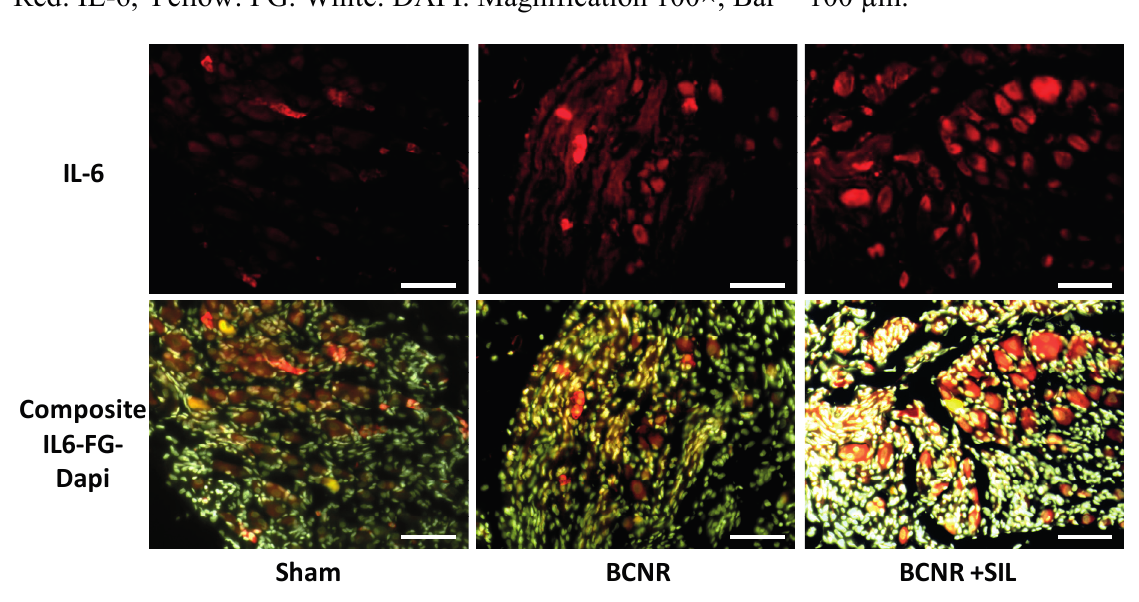
Figure 3. Sildenafil up-regulates the expression of IL-6 in the pelvic ganglia after BCNR. Frozen pelvic ganglia sections were immunostained with a polyclonal antibody against IL-6 followed by a biotinylated secondary antibody and streptavidin conjugated with Texas